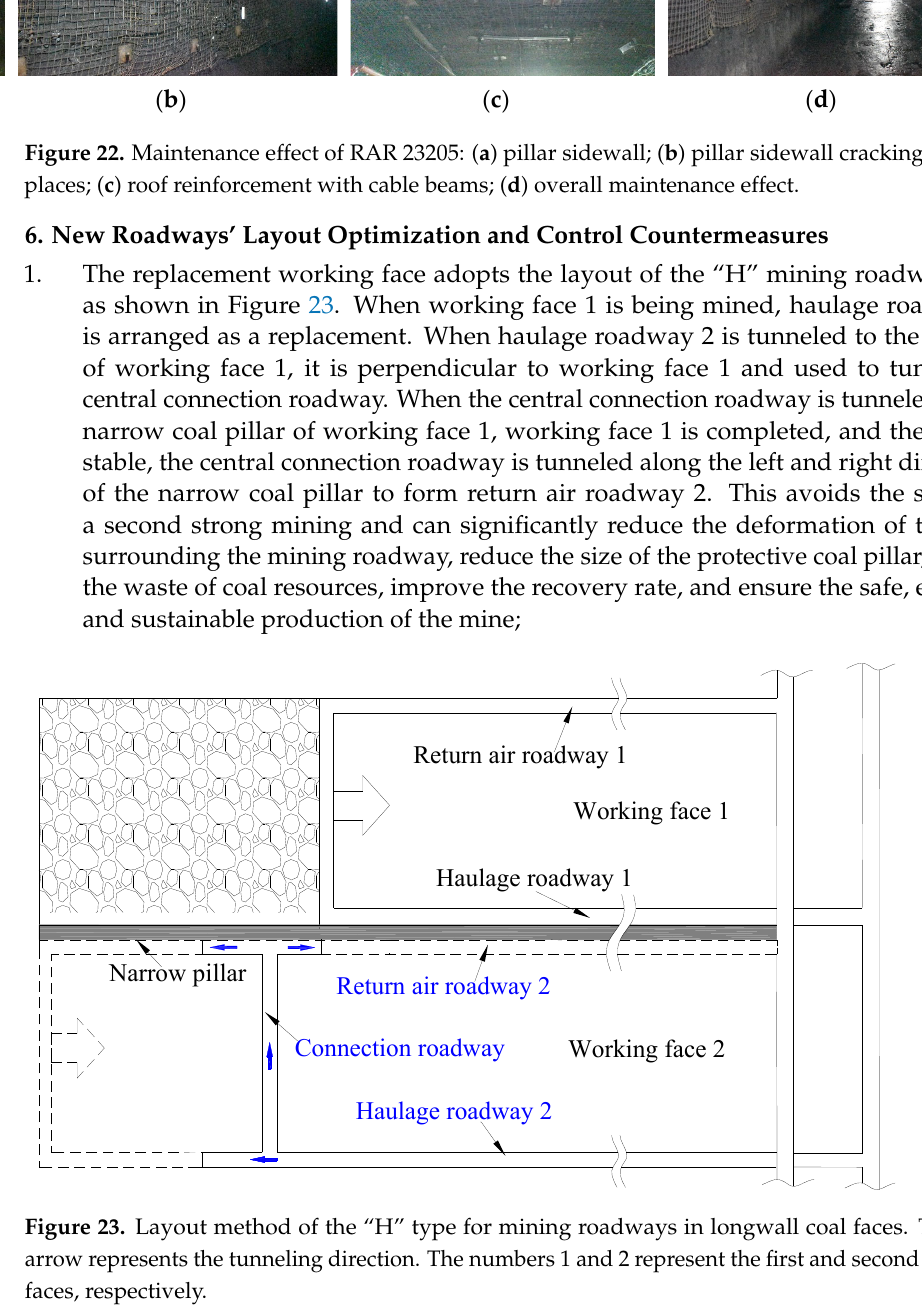
working faces, respectively. faces,